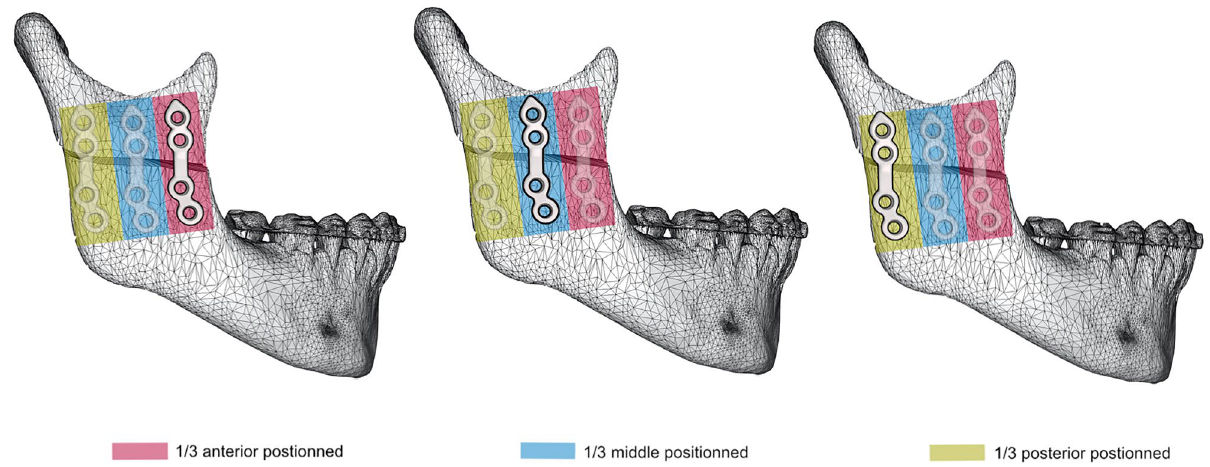
Figure 3. Areas available for mini-plate fixation in high oblique sagittal split